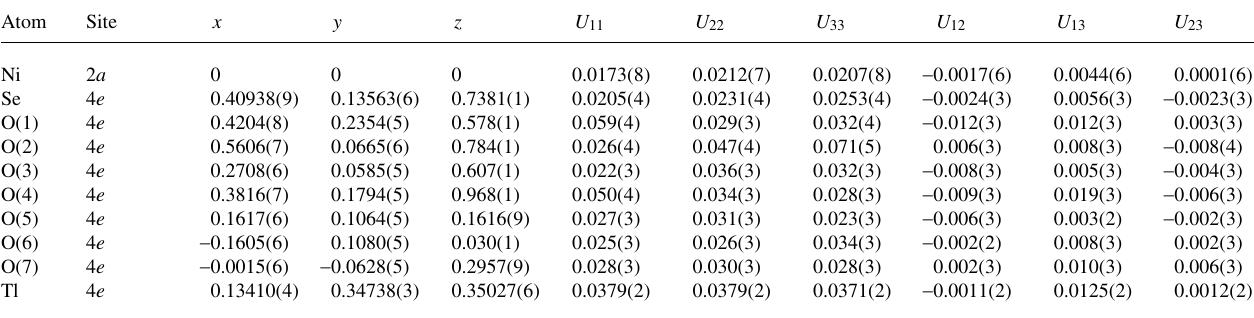
Table 12. Atomic coordinates and displacement parameters (in Å 2 ) .